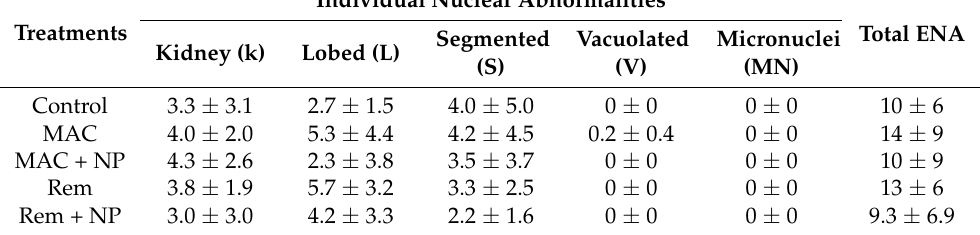
Table 2. Mean frequency (‰) of each nuclear abnormality category (mean ± standard deviation) in the peripheral erythrocytes of turbot ( S. maximus ) exposed to different metallic mixtures, with and without nanoparticles, for 7 consecutive days. Values (‰) concern the sum of frequencies for all of the nuclear abnormality categories scored (ENA frequency) and the frequency of each abnormality category individually. MAC—maximum concentrations allowable for effluents discharges; Rem— MAC concentrations after remediation processes; MAC + NP—maximum concentrations allowable for effluents discharges plus Ag-NP and Au-NP; Rem + NP—MAC concentrations after remediation processes plus Ag-NP and Au-NP.